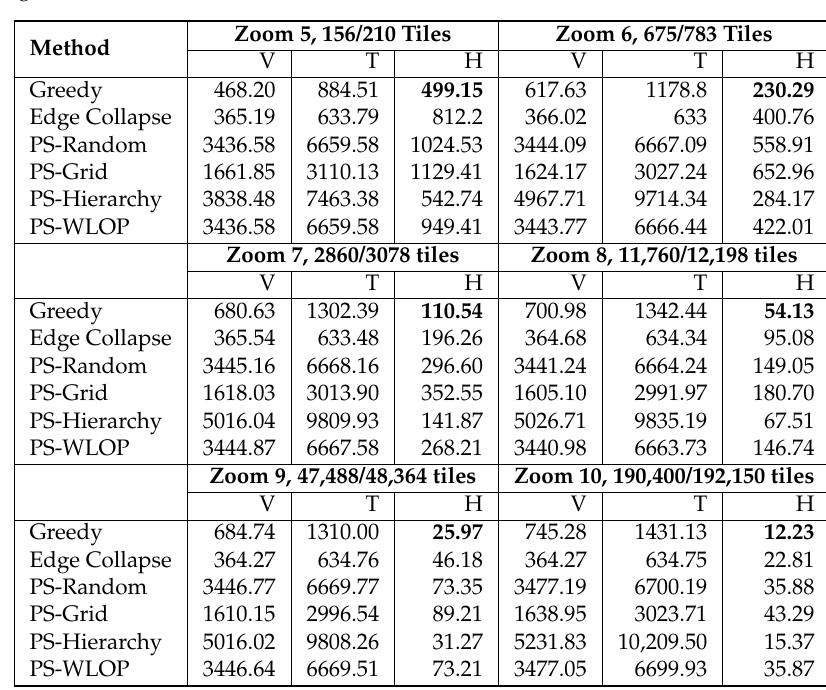
Table 4. The quantitative check for the simplification results of the European Marine Observations Data network (EMODnet) digital terrain model (DTM). The V, T, and H columns refer to the mean value of the number of vertices, the number of triangles, and the symmetric Hausdorff distance (meters), computed from all the tiles in each zoom. Next to each zoom, we present the number of tiles used for computing the statistics from the total number of tiles in the